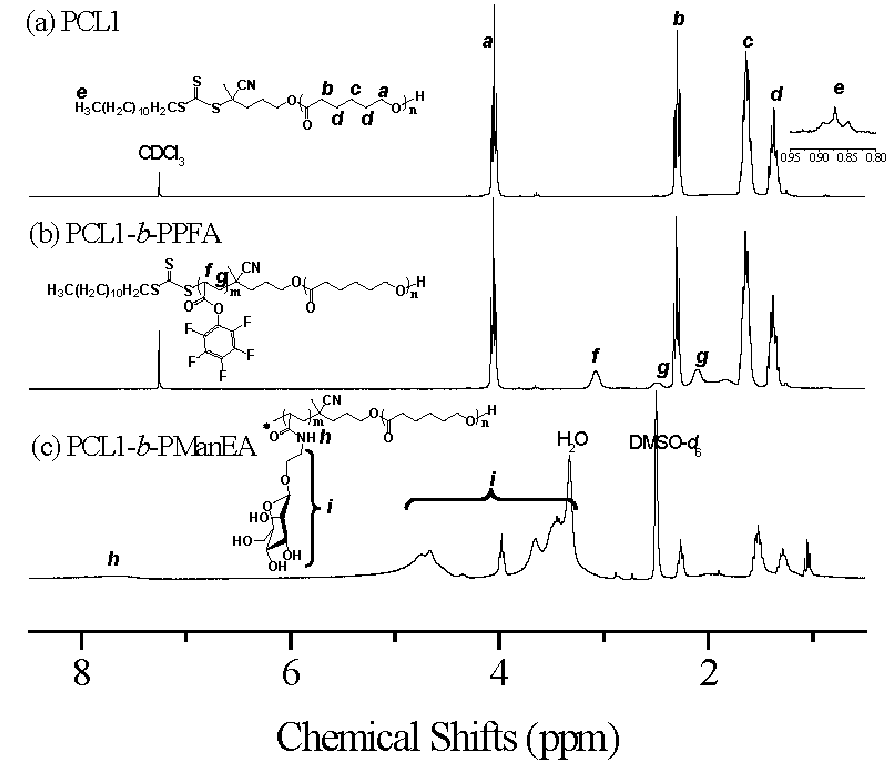
Figure 1. 1 H NMR spectra of: ( a ) PCL1 homopolymer; ( b ) PCL1- b -PPFA; and ( c ) PCL1- b -PManEA block copolymers.